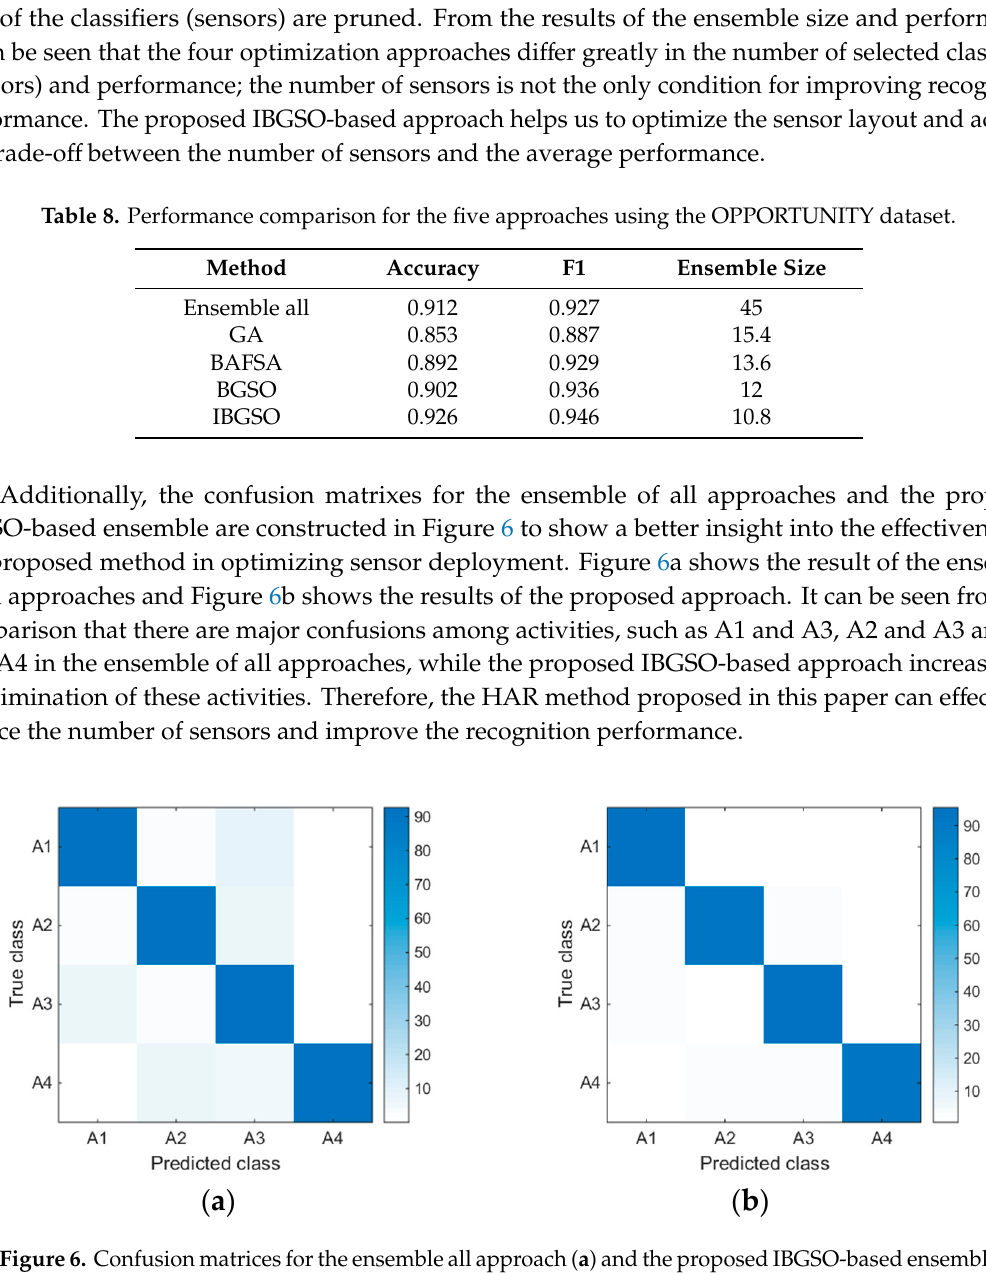
Figure 6. Confusion matrices for the ensemble all approach ( a ) and the proposed IBGSO-based ensemble approach ( b ) using the OPPORTUNITY dataset.